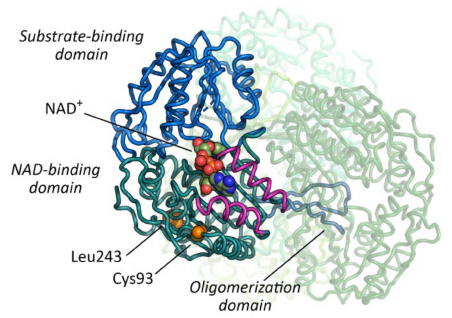
Figure 3. Tetrameric structure of human SSADH (PDB code: 2w8o ). The substrate-binding domain, nicotinamide adenine dinucleotide (NAD + ) -binding domain and oligomerization domain of the reference monomer are colored in di ff erent shades of blue. The other three monomers are represented by transparent shades of green. The two α -helices in close contact with the adenosine monophosphate moiety of NAD + are colored in purple. Proteins are represented as tubes, while NAD + and the mutated residues (Cys93 and Leu243, α C- α C distance: 20.8 Å) are represented by Van der Waals spheres. The NAD + molecule has been modelled into the NAD + -binding domain based on the published structure of the human SSADH in complex with adenosine diphosphate moiety as a ligand (PDB code: 2w8r)